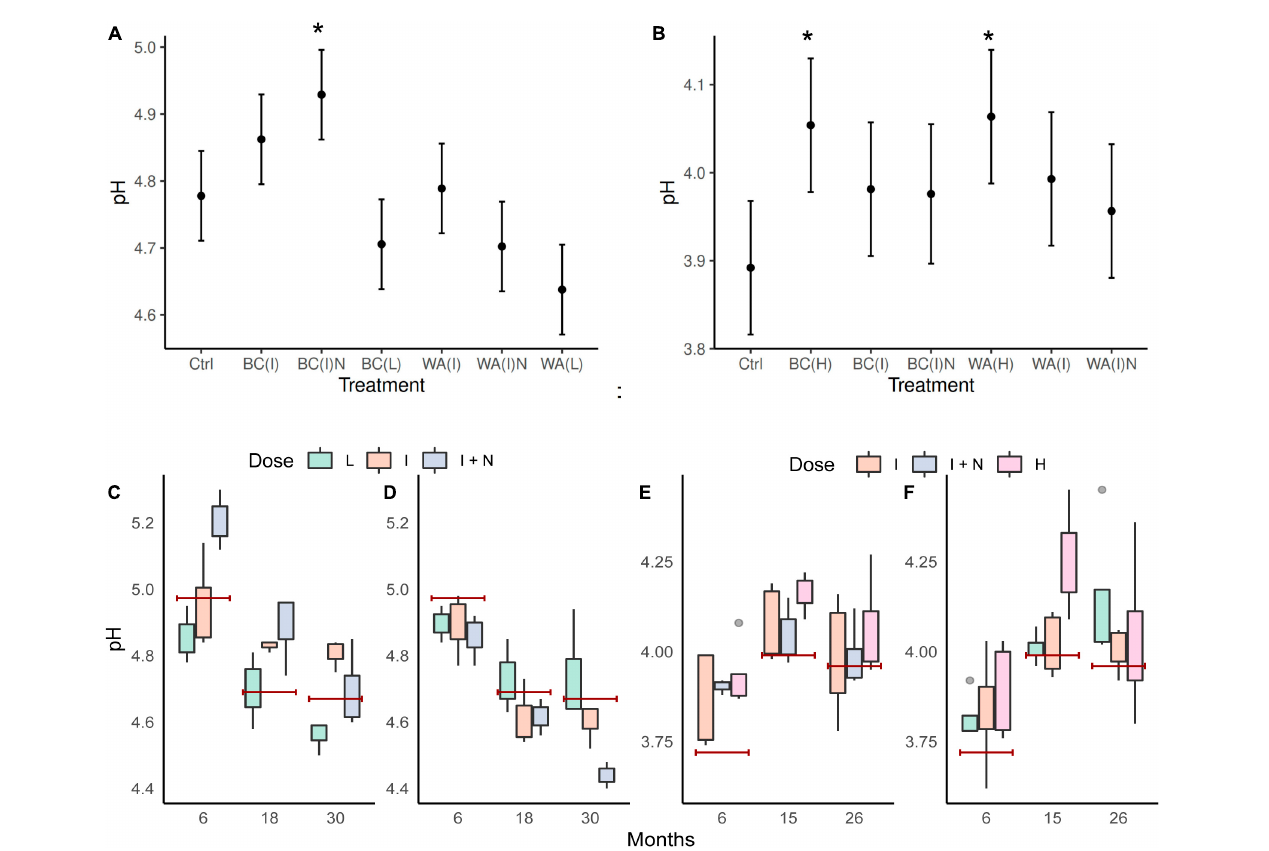
FIGURE1 Representation of estimated Marginal Means (EMM) of soil pH (top) by treatment and experimental site: Experimental site of Karrantza [ES-K, (A) and Experimental site of Oiz (ES-O, (B) ], and boxplots showing soil pH values of each experimental site (bottom): ES-K (C,D) and ES-O (E,F) during time (X-axis). Values for biochar (BC) treatments are represented by boxplots c and e, and wood ash (WA) treatments are represented by boxplots (D,F) . EMM of control is represented in the boxplots by red lines, to provide a visual comparison. High dose (H, purple), intermediate dose (I, pink) and low dose (L, green); 0.8% of N (always with intermediate rate), (I + N, blue). Boxes show the density data within the first to the third quartile of the dataset for each treatment. The horizontal line inside the box represents the median value. The upper and lower whiskers extend from the higher to the lower pH data. Means which differ significantly from control are in bold and mark with asterisks (* p <